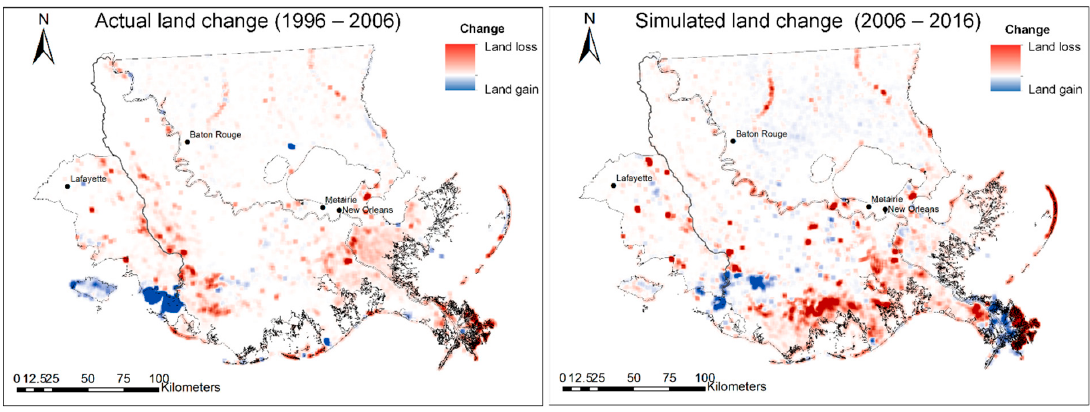
Figure 7. Maps showing actual land loss from 1996–2006 ( left ) and simulated land loss from 2006–2016 ( right ).